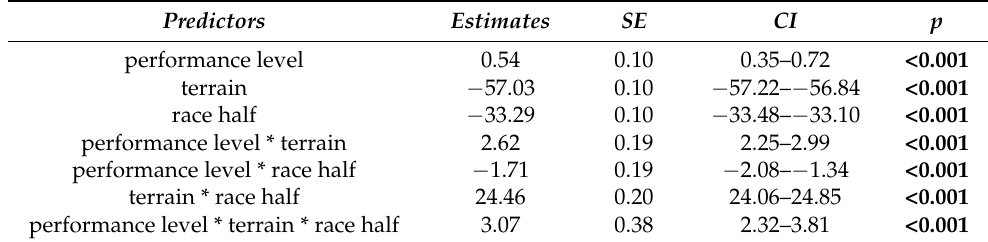
Table 1. Linear mixed effect model output for the full dataset; significant results are highlighted in bold.